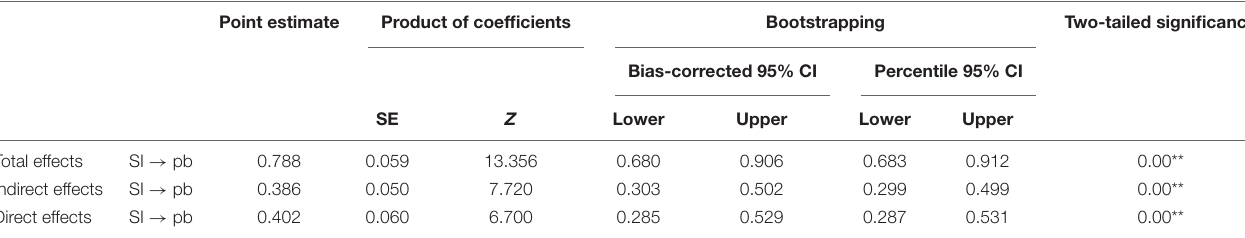
TABLE 6 | Unstandardized direct, indirect, and total effects of the hypothesized